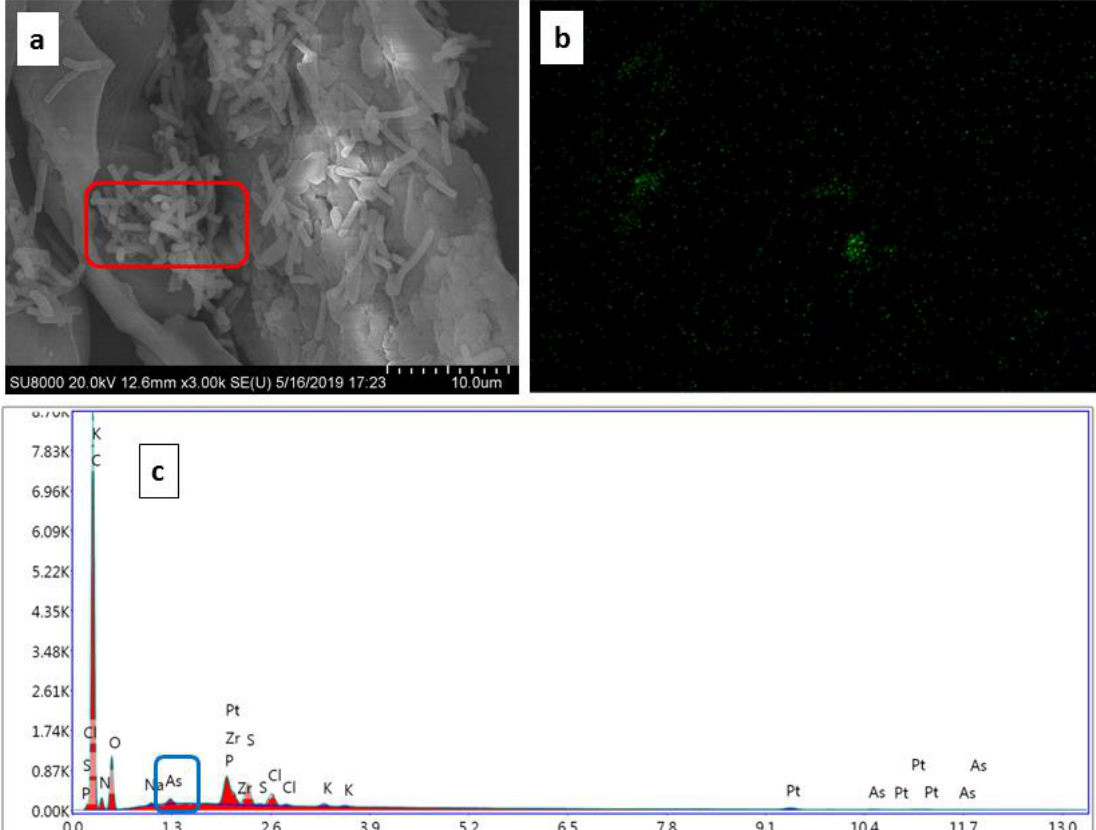
Figure 4. Arsenic accumulation and bacterial immobilization on BCXZM composite in optimized experiment. ( a ) SEM micrograph; ( b ) elementary overly of arsenic; and ( c ) EDX graph of the BCXZM composite in optimized experiment.